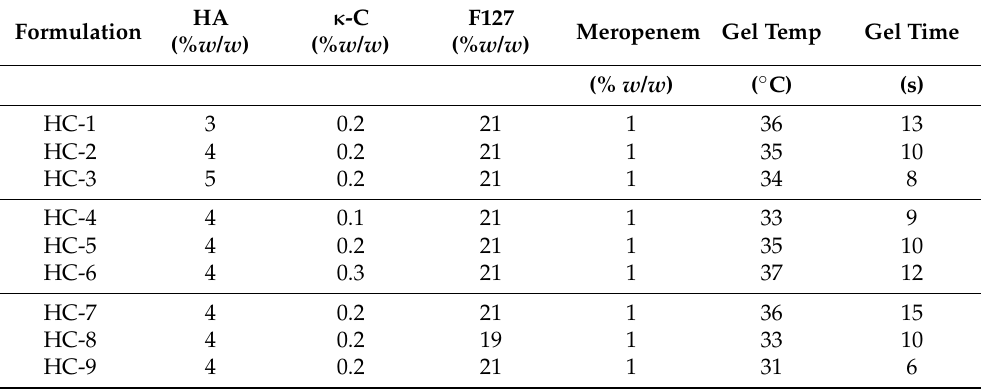
Table 1. Hyaluronic-acid– κ -carrageenan-based F127 thermosensitive hydrogel feed composition.